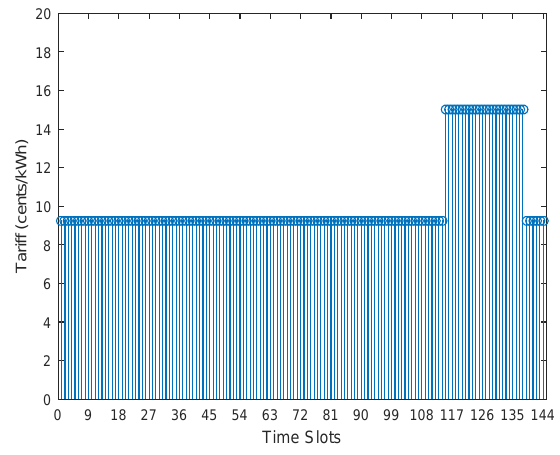
Figure 4. Two-stage time-of-use tariff